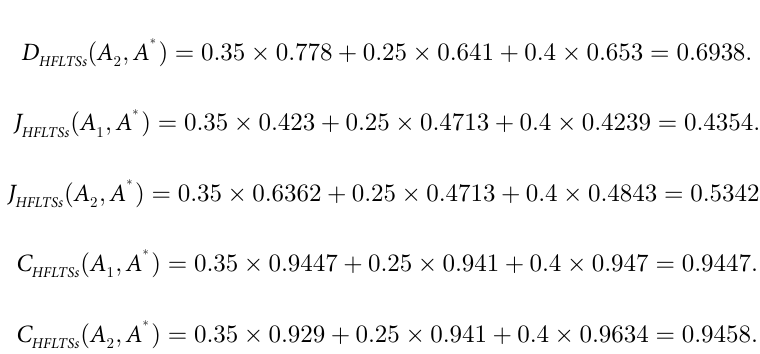
Table 4. Similarity values of J